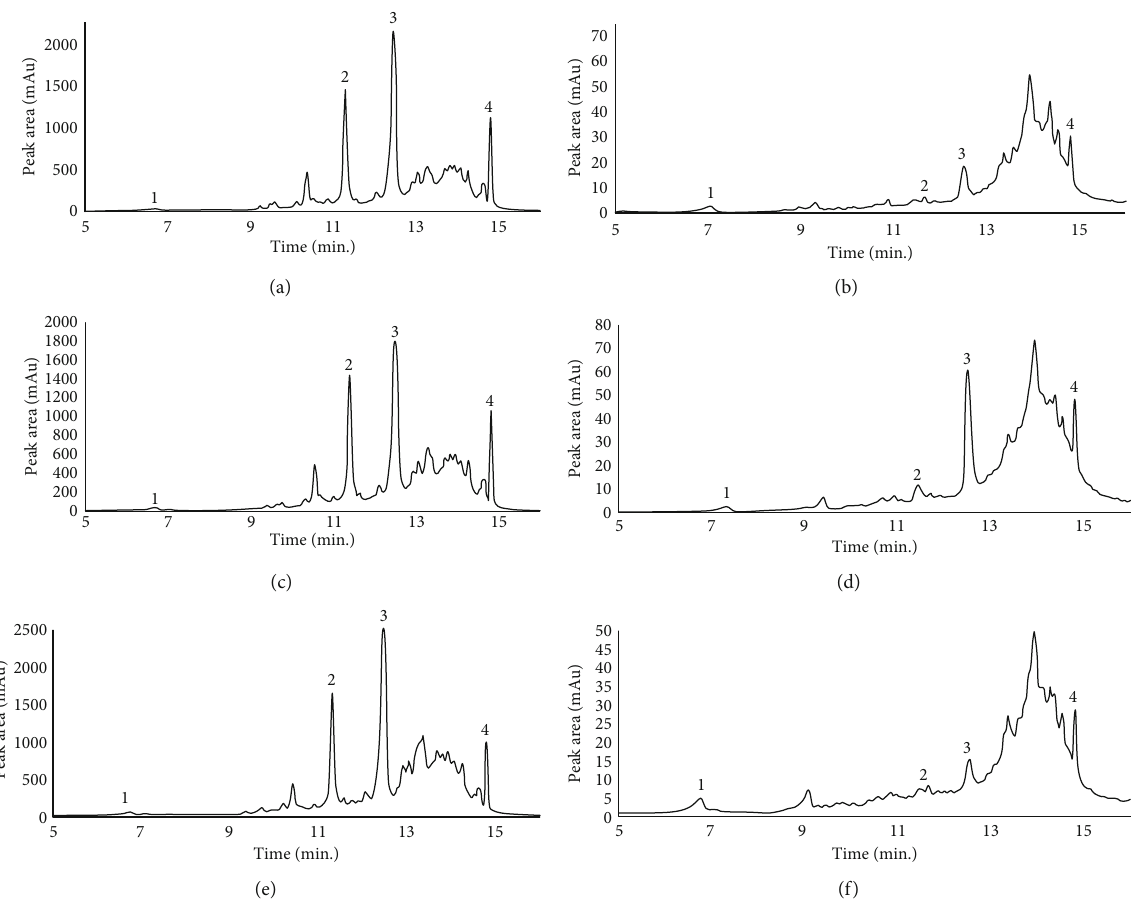
Figure 1: UHPLC-DAD chromatogram of the polyphenol extract of pomegranate peel powder ((a) Beni Mellal, (c) Settat, (e) Berkane) and pomegranate seed powder ((b) Beni Mellal, (d) Settat, (f) Berkane). Phenolic compounds were detected at 280nm; the peaks were assigned to (1) gallic acid, (2) α -punicalagin, (3) β -punicalagin, and (4) ellagic